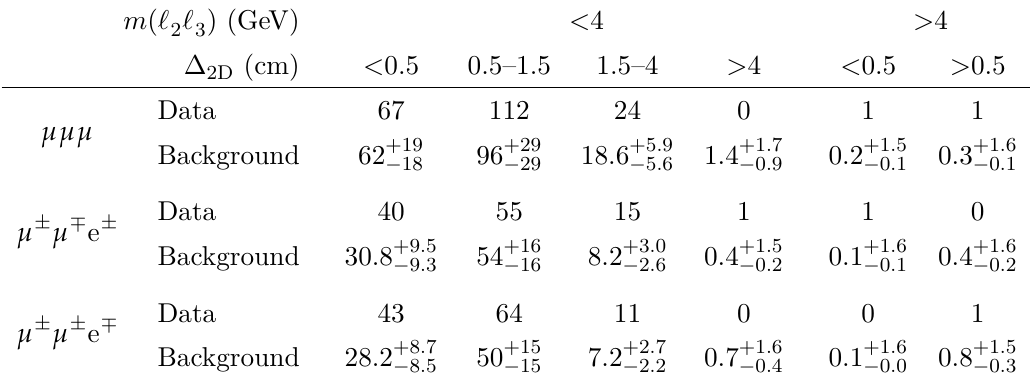
Table 4 . Number of predicted and observed events in the mm X final states. The quoted uncertain- ties include statistical and systematic components.